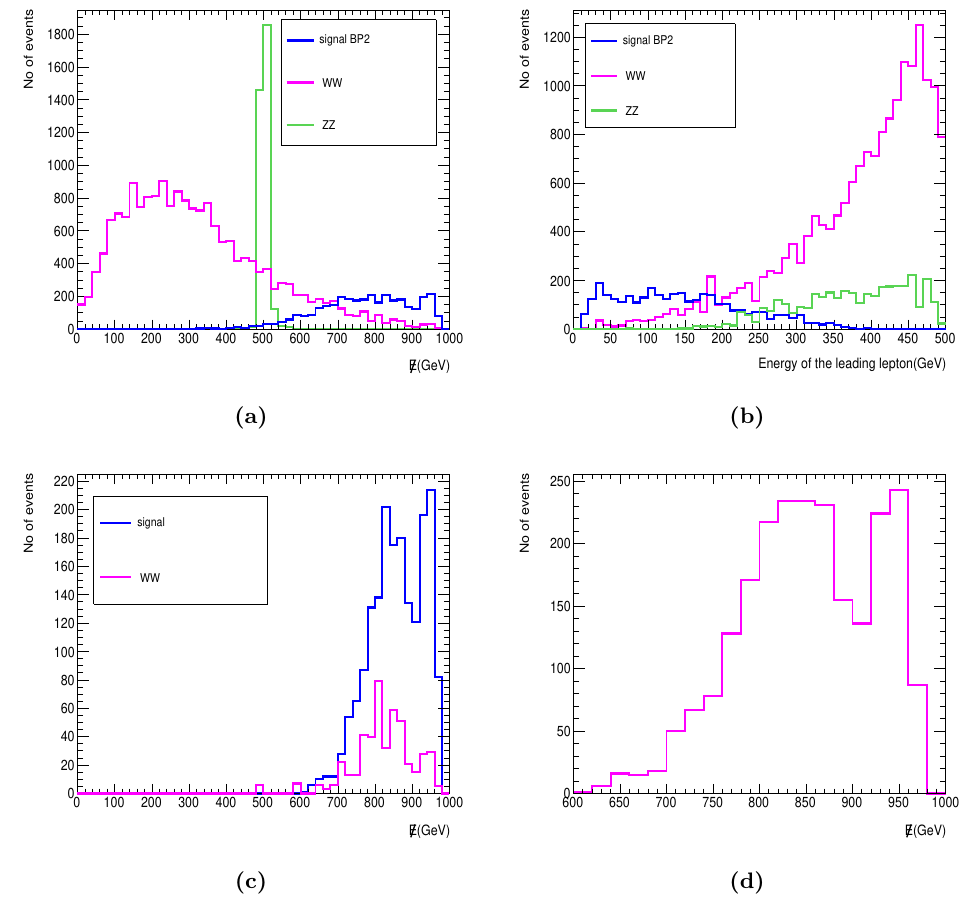
Figure 13. Same as figure 12 but for